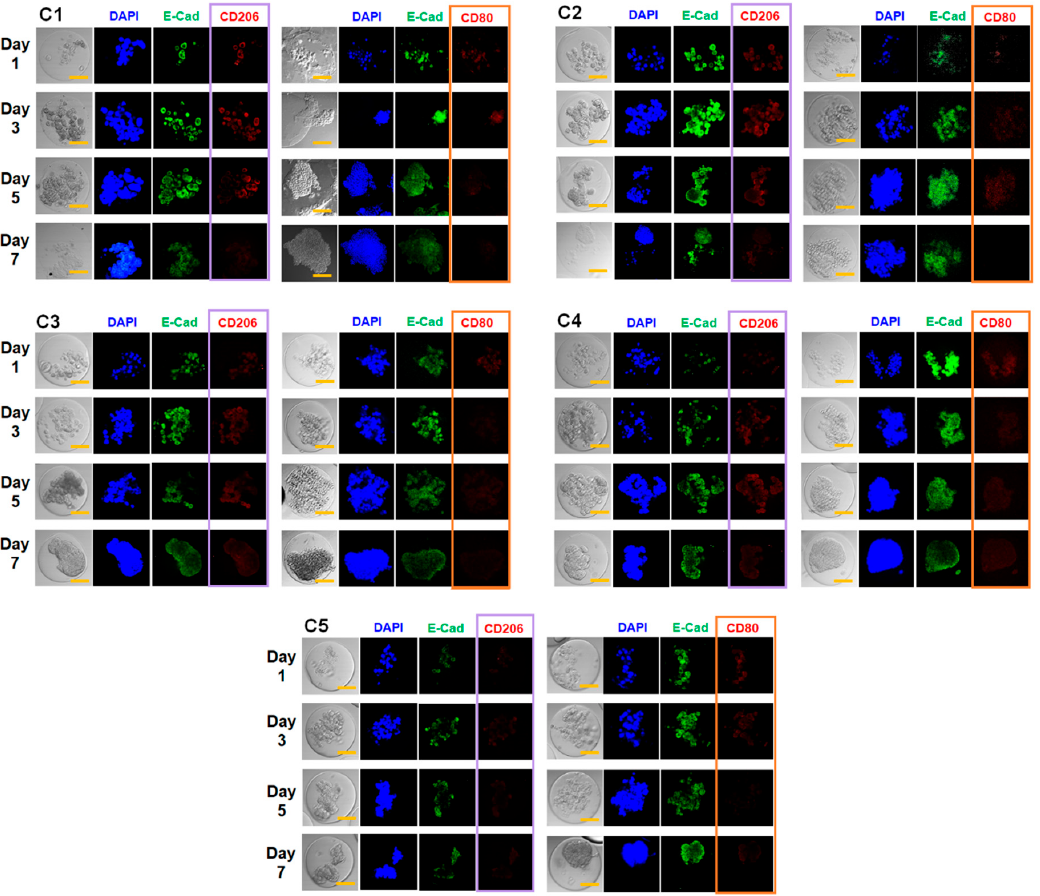
Figure 8. Immunocytochemical analysis of MCF-7 cells and macrophages encapsulated in microgels with varying mechanical properties (from C1 to C5). At various times up to 7 days, E-cadherin (E-cad), CD206, and CD80 were fluorescently labeled (scale bar: 50 μ m). 4 ′ ,6-diamidino-2-phenylindole (DAPI) was used to label cell nuclei.